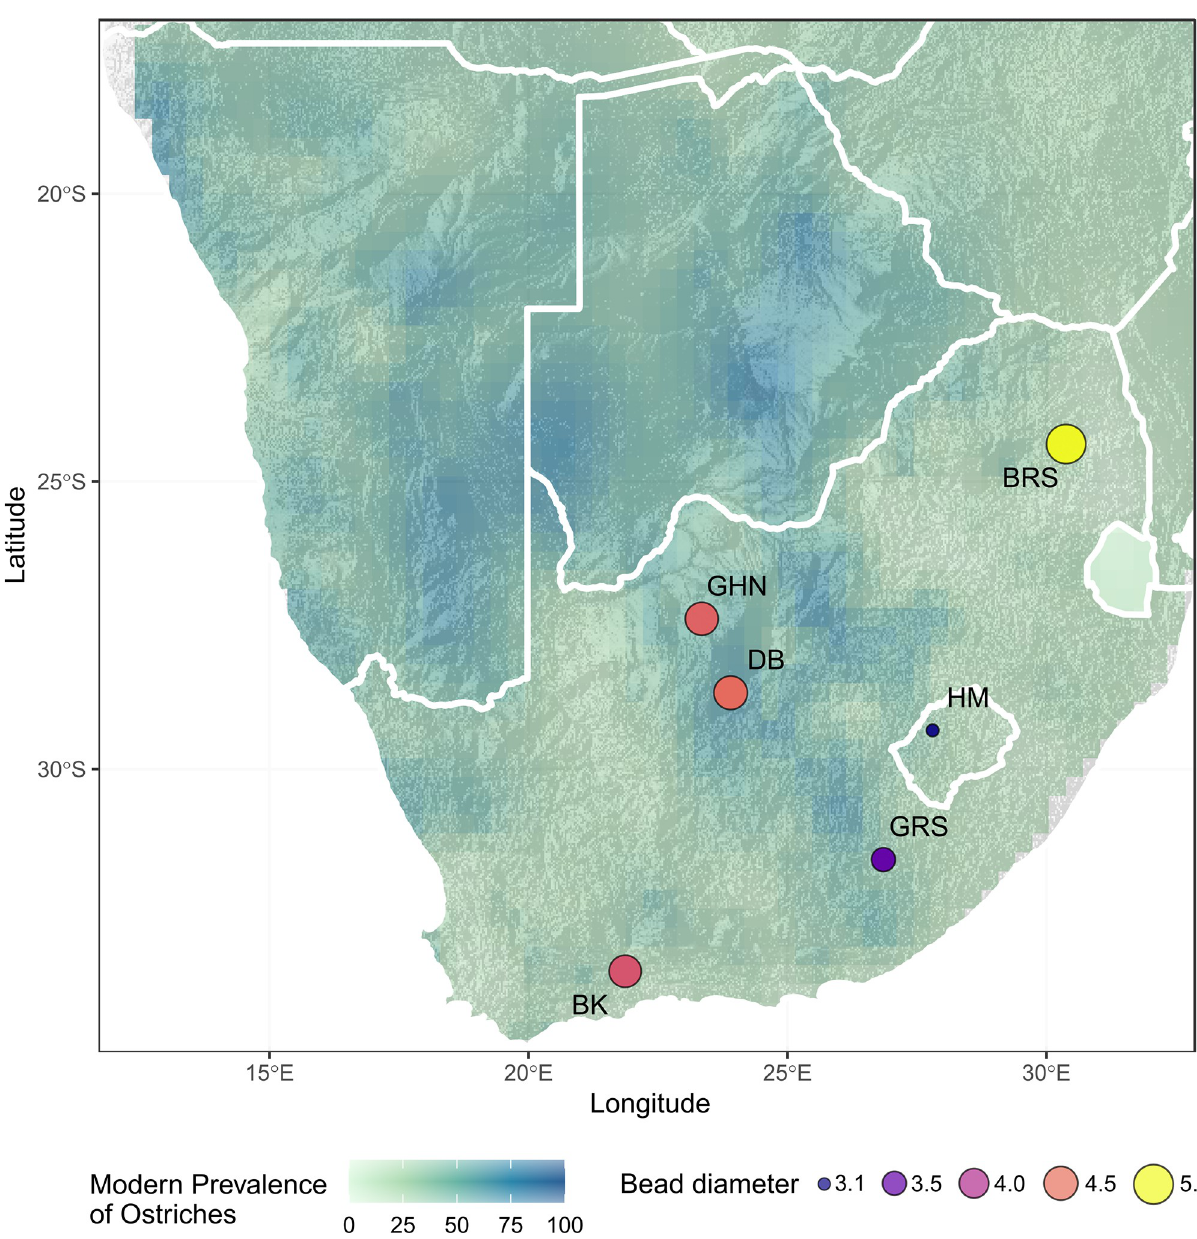
Fig 8. Map of southern Africa showing archaeological sites dated to MIS 2 that have OES bead assemblages. Mean OES bead diameters for sites, overlaid on a map of modern ostrich prevalence based on South African Bird Atlas Project 2 data [60]. BK–Buffelskloof, GHN–Ga-Mohana Hill North, DB—Dikbosch, GRS—Grassridge Rockshelter, HM-Ha Makotoko, BRS–Bushmans